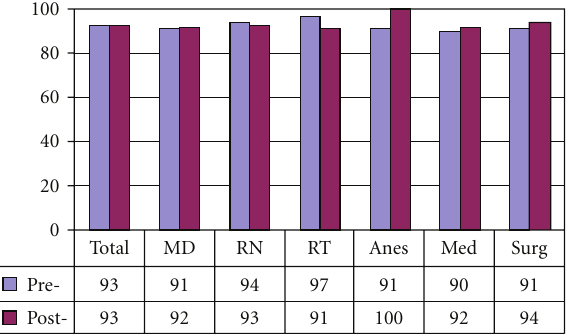
Figure 6: Do not blindly reinsert recently operated tracheotomy tubes (%